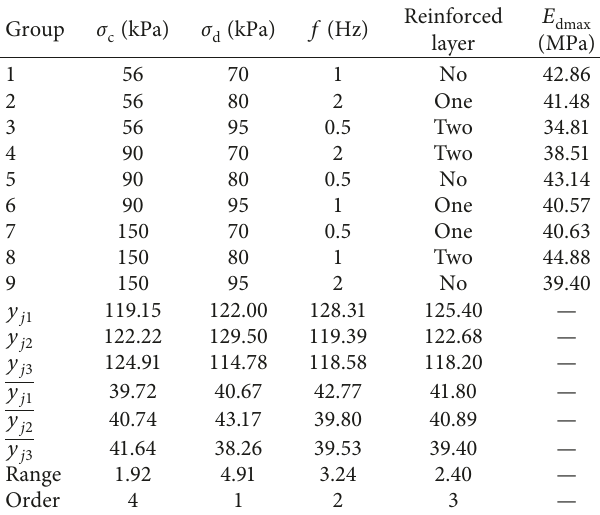
Table 6: Results of orthogonal design of